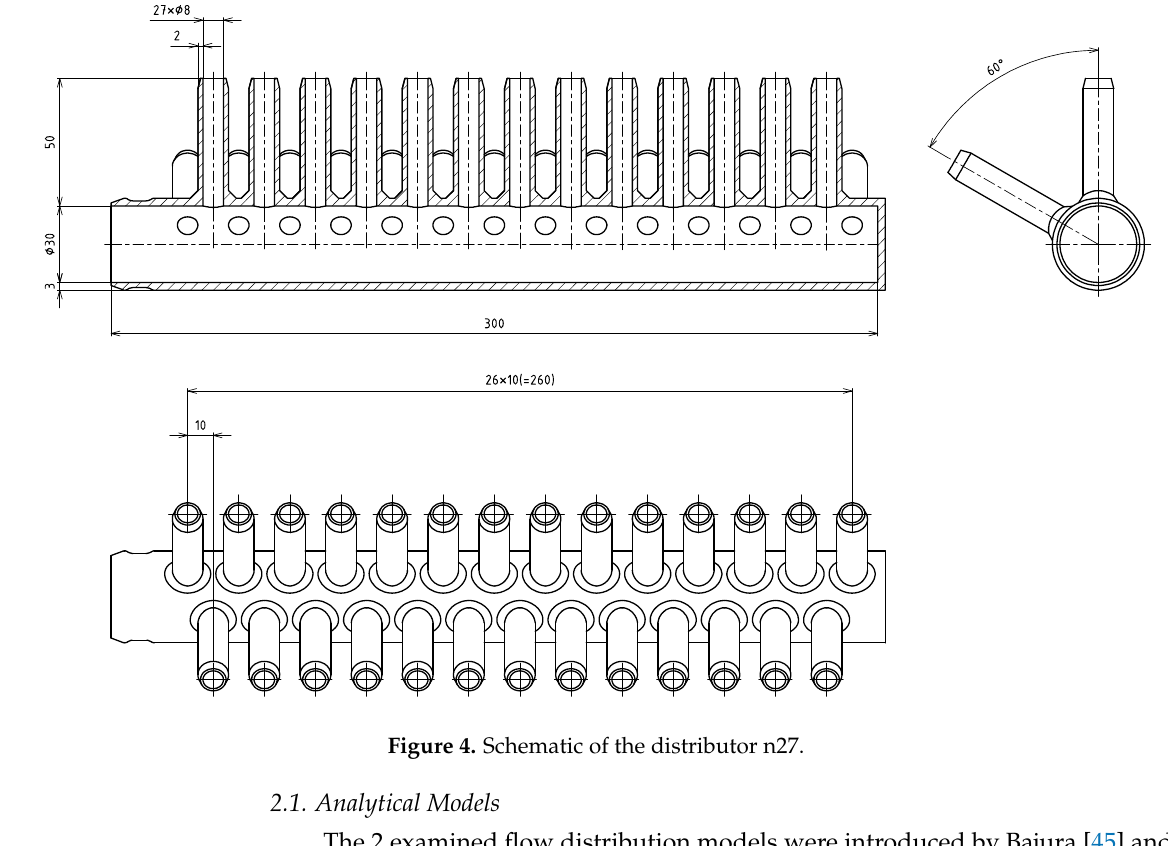
Figure 4. Schematic of the distributor n27.